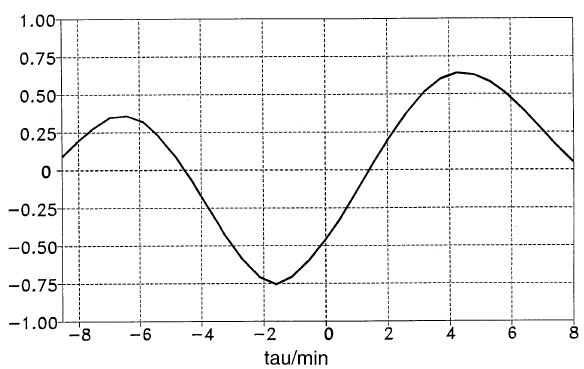
Fig. 8. Cross-correlation function of the two temporal variations shown in Fig. 6 for the time interval from 15 to 50